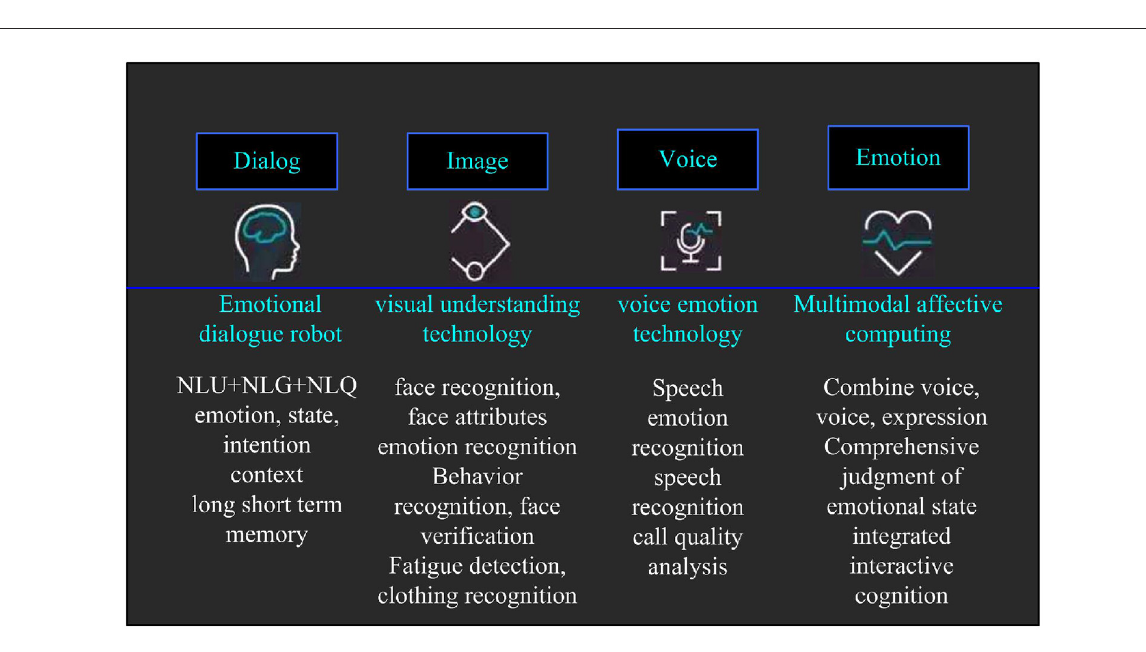
FIGURE2 Emotion recognition model